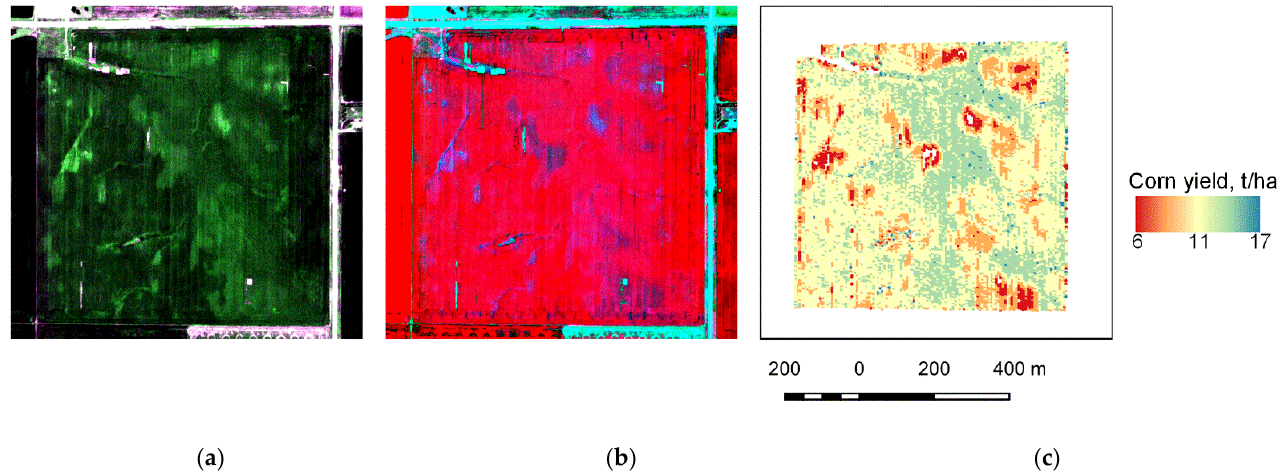
Figure 4. Example of WorldView-3 (WV-3) images acquired over the Coles corn field on 2 July 2018. True color composite red-green-blue ( a ); false color composite near infrared (NIR)-red-green ( b ); corn yields ( c ). © 2021 DigitalGlobe, Inc., a Maxar company, NextView License.